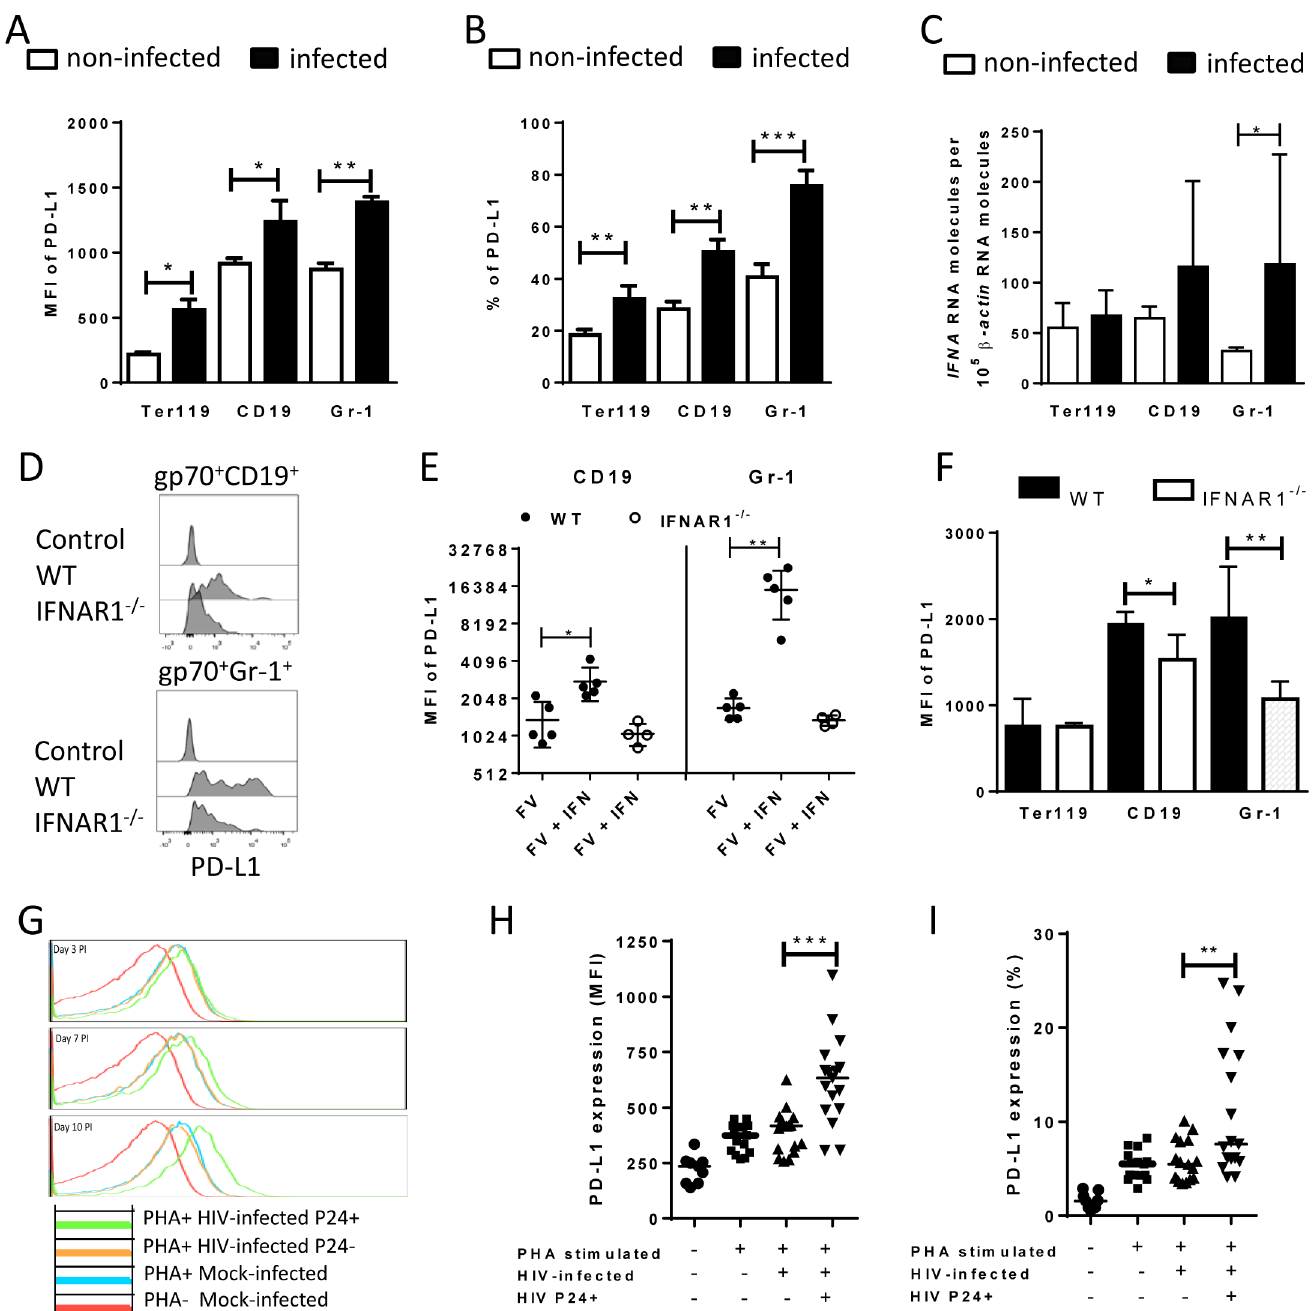
Fig 3. PD-L1 expression on cells infected in vitro with FV or HIV. Spleen cells were isolated from naive B6 mice and cultivated with F-MuLV infected Mus Dunni cells to infect mouse cells in vitro. Multi-parameter flow cytometry was used to determine PD-L1 expression (MFI) ( A ) and the percentage of PD-L1 high cells ( B ) in different target cell populations of FV. C . Ter119 + , CD19 + , and Gr-1 + cells were isolated from na ï ve wild type mice and were infected with F-MuLV in vitro . mRNA from infected and non-infected cells was isolated for real time PCR quantification of the IFN α mRNA expression. The numbers of IFN α